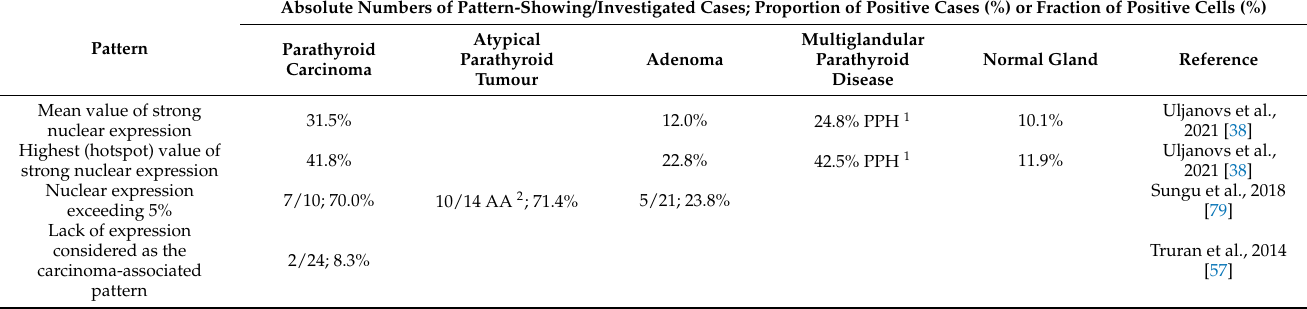
Table 5. Expression of cyclin D1 in parathyroid tumours and